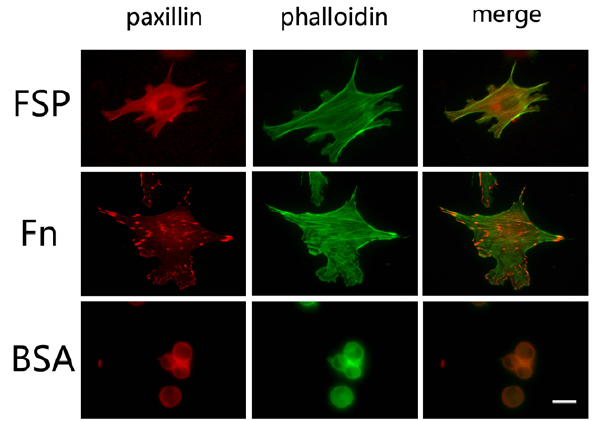
Figure 5. The effect of calcium on the attachment of LEC to FSP. 96-well plates were coated with FSP(10 ug/m) or Fn (10 ug/m) diluted in HBS containing either 1 mM CaCl 2 or 0.5 mM EGTA for 2 hr at 37 u C.Trypsin-released LEC were re-suspended in HBS containing either 1 mM CaCl 2 or 0.5 mM EGTA and plated on precoated plates for 2 hr at 37 u C. Cells were stained with 0.1% crystal violet, and representative photographs are shown.